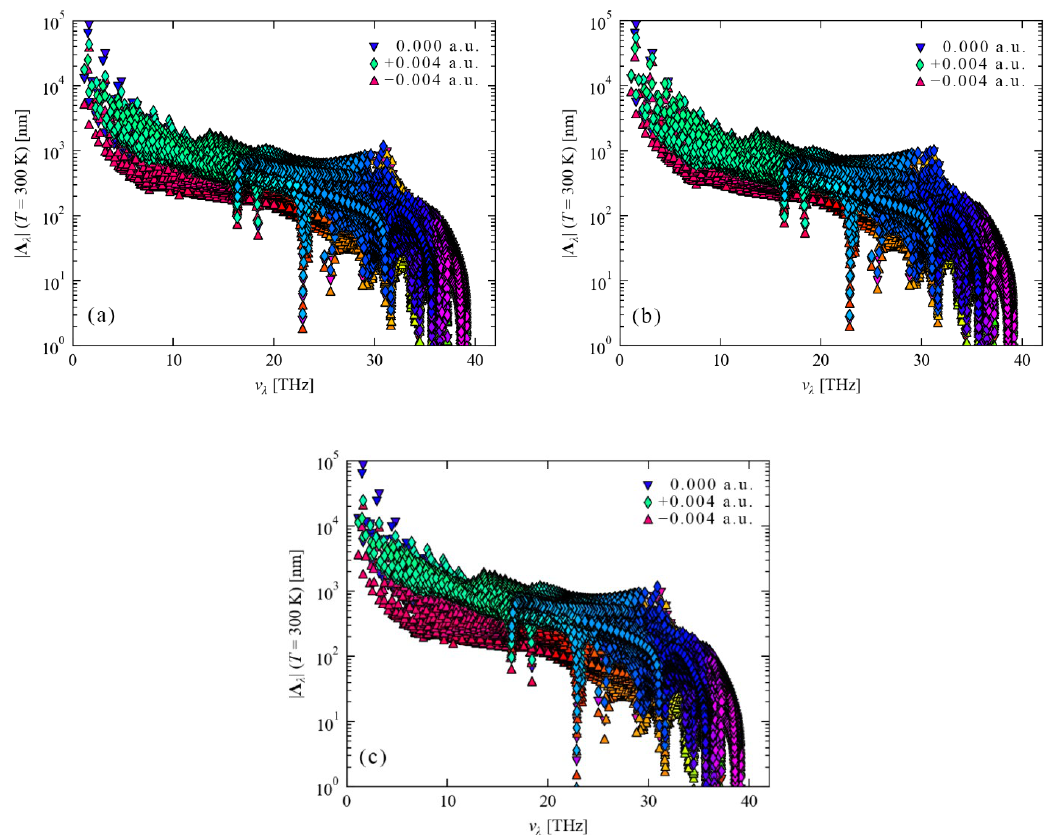
Figure 16. Phonon mean free path after applying ± 0.004 a.u. electric field in diamond [001], [110] and [111] crystallographic orientations. An electric field is applied in the [001] crystallographic direction ( a ), an electric field is applied in the [110] crystallographic direction ( b ) and an electric field is applied in the [111] crystallographic direction ( c ).